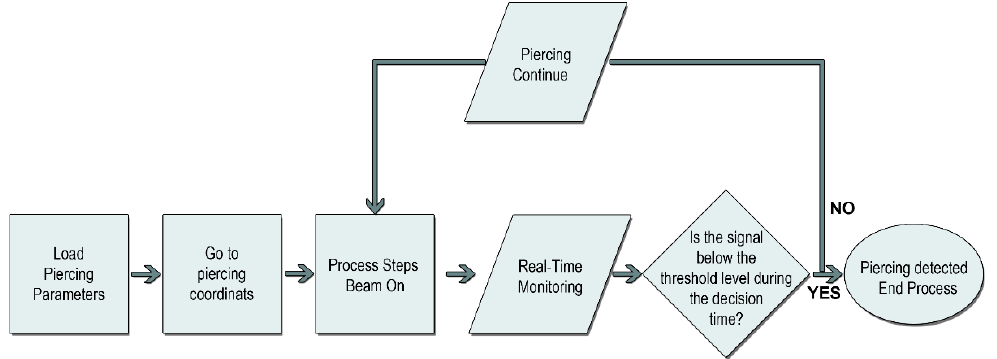
Figure 2. Piercing detection algorithm in high-power fiber laser